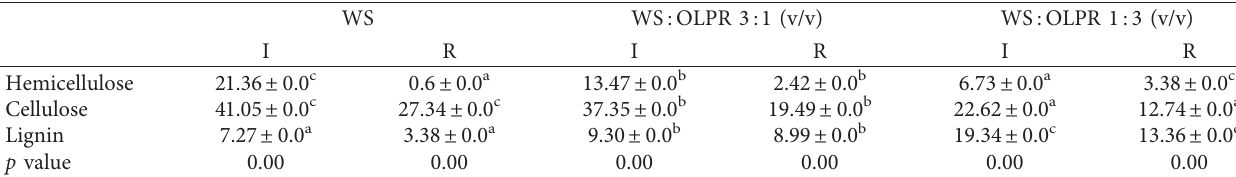
Figure 1: Relation between organic matter loss (OML) and proportions of olive pruning residues (OLPRs) (OML � − 0.32 × OLPR +75.76) ( r 2 � 0.85). Table 3: Digestibility of fiber fraction (% dry weight) components.